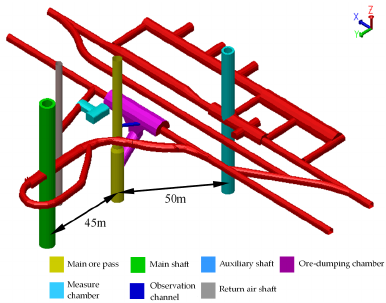
Figure 9. Location plan of the main ore pass.